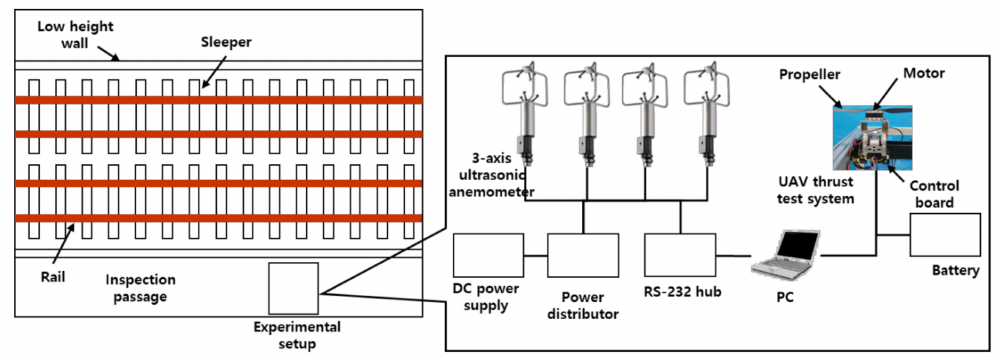
Figure 1. Schematics of the train-induced wind and unmanned aerial vehicle (UAV) thrust measurement systems installed on top of the Wolsan